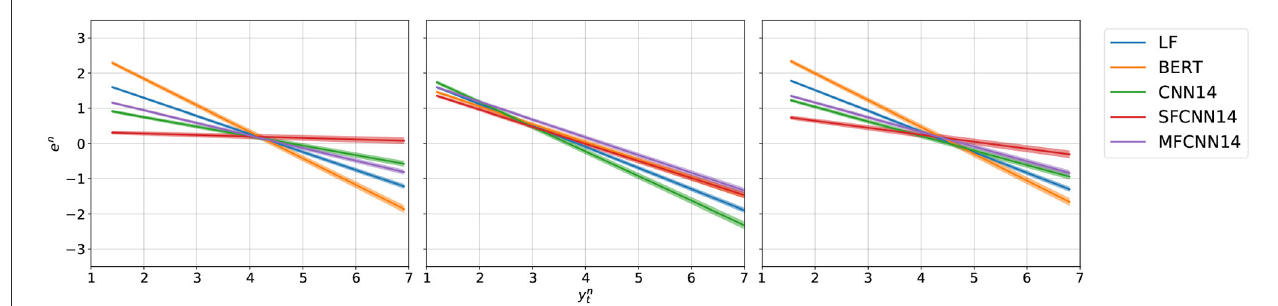
FIGURE4 Error residual plots for arousal (left) , valence (middle) , and dominance (right) . Linear curves fitted on error residuals ( e n = y n t − y n p ) for each architecture and dimension and plotted against the gold standard ( y n t ). With the exception of SFCNN14 on arousal, all models show higher errors toward the edges of their scale. Plots best viewed in